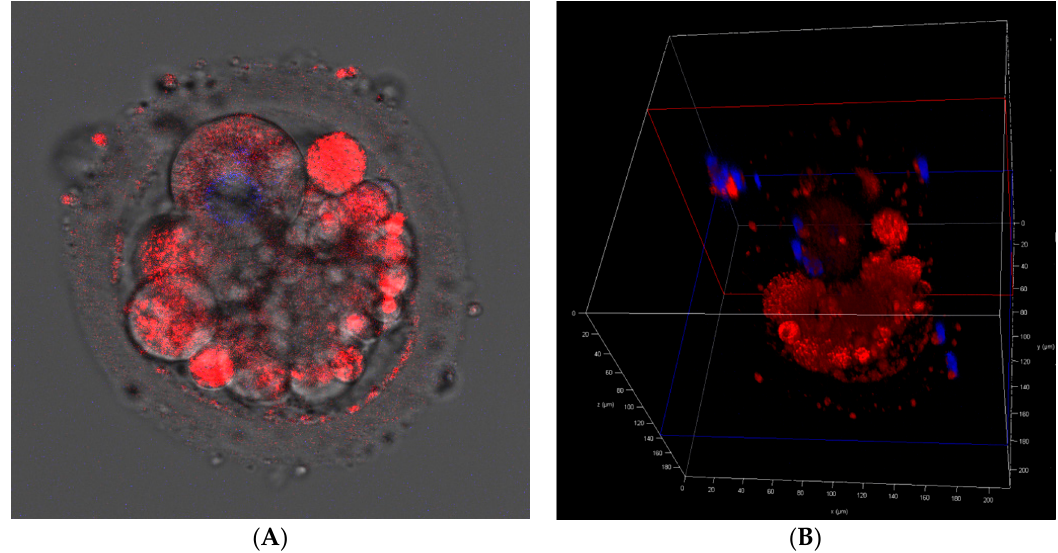
Figure 5. ( A ) - the MitoTracker Red CMXRos (Invitrogen, , Ipswich, Massachusetts , United States)- Figure 5. ( A )—the MitoTracker Red CMXRos (Invitrogen, Ipswich, MA, USA)-stained day-3 embryo. stained day-3 embryo. Mitochondria are stained red, nuclei are stained blue. ( B )—the embryo in the Mitochondria are stained red, nuclei are stained blue. ( B )—the embryo in the 3D 3D cross-section.